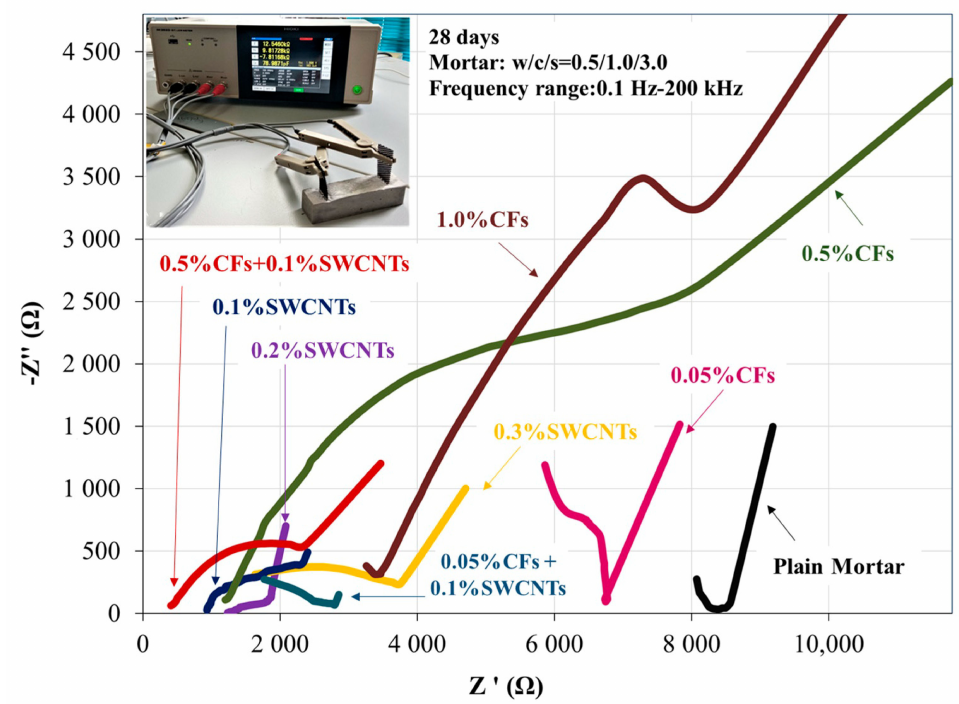
Figure 9. Nyquist plot of a 28-day nano-, micro-, and hybrid-reinforced cement mortar matrix with different concentrations of carbon nanotubes (SWCNTs) and carbon microfibers